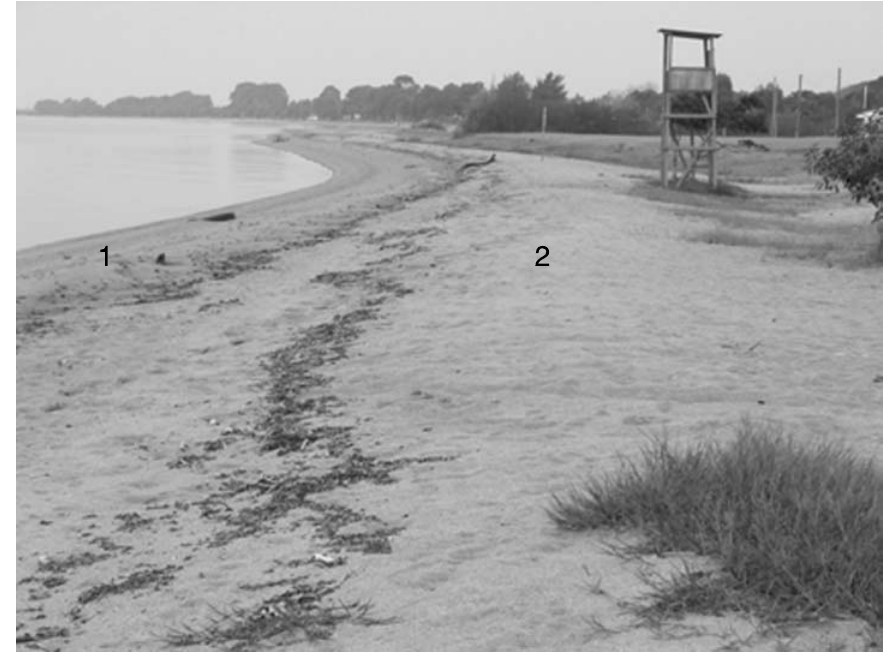
Fig. 2a – Active, modern berm (1 – near the water) and beach ridge (2 – center of photograph) forming on the Patos Lagoon at Arambare, Rio Grande do Sul. The berm is eroded, accreted, re-formed or destroyed by swash operating at various lake levels, and largely destroyed during high water level storm events (i.e. it is generally non-persistent). The beach ridge is formed at high water levels during storms and higher wave energy events by swash and is generally persistent.